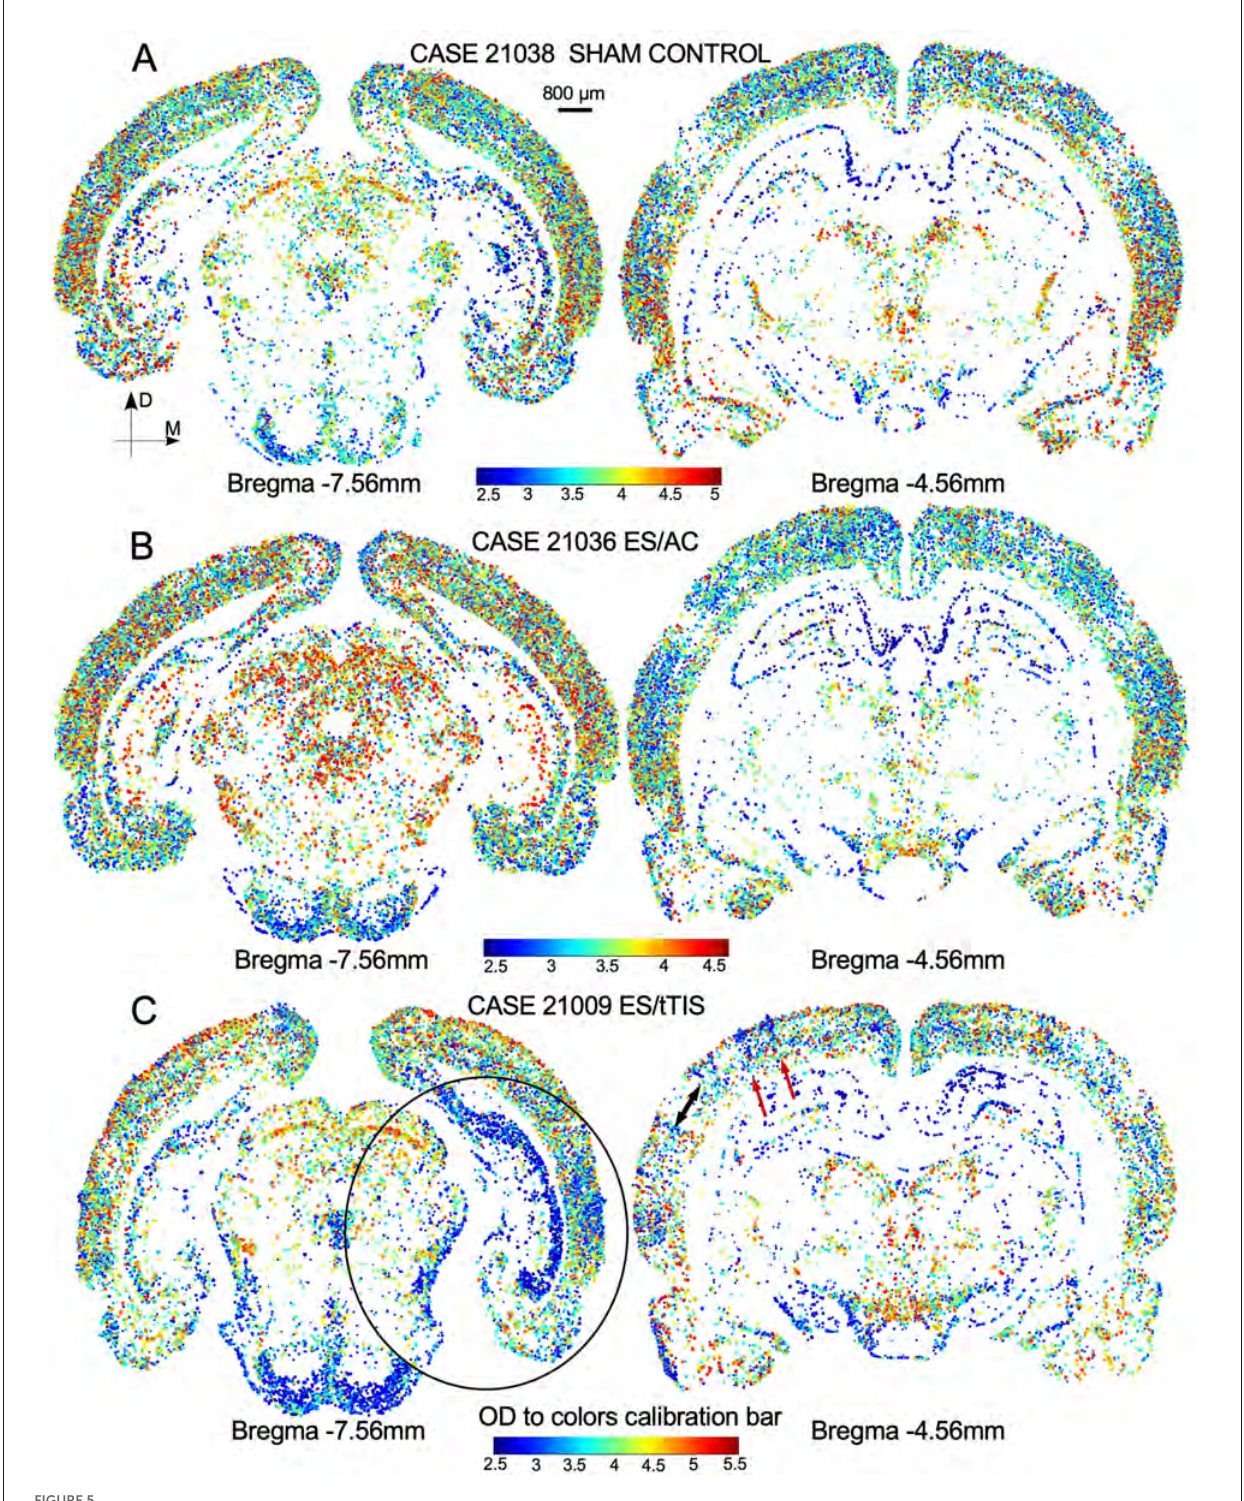
FIGURE5 MATLAB maps of two representative sectioning levels (caudal left and rostral right column) from (A) Sham Controls, (B) ES/AC, and (C) ES/tTIS at equivalent coordinates. (B) ES/AC maps show the same cytoarchitectonic organization as the maps of sham controls (compare with A ). (C) ES/tTIS maps show a decreased number of cells with areas devoid of staining (black double arrow), particularly at Bregma -4.56 mm (right column). At these coordinates, cortical cytoarchitectonic borders are blurred and orthogonal rows of cells (red arrows) can be seen. At the caudal level (left section Bregma -7.56 mm), the cell population shows an asymmetric distribution, especially in the right hippocampus and around the ventral temporal associative (TeA) cortex (circle). Insets in the bottom of the maps show the optical density-to-color calibration